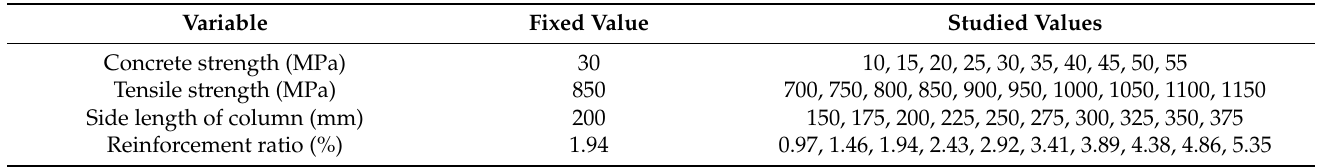
Table 5. Ranges of the parameters during the parametric investigation.